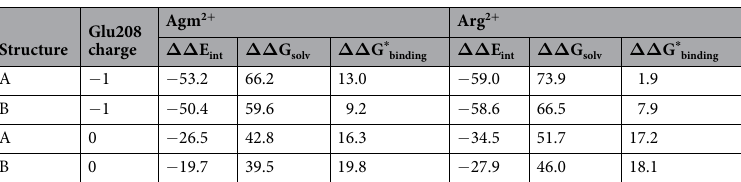
Table 3. Free energies of binding calculated using a QM procedure. Difference in binding free energy without configurational entropy ( ΔΔ G * binding ), difference in total solvation energy ( ΔΔ G solv ), and difference in gas- phase interaction energy ( ΔΔ E int ) (Eq. 3) for Arg 2 + and Agm 2 + with respect to Arg + used as a reference. All energies were computed for both monomers (A and B) and both Glu208 protonation states in 3OB6. All energy values are given in